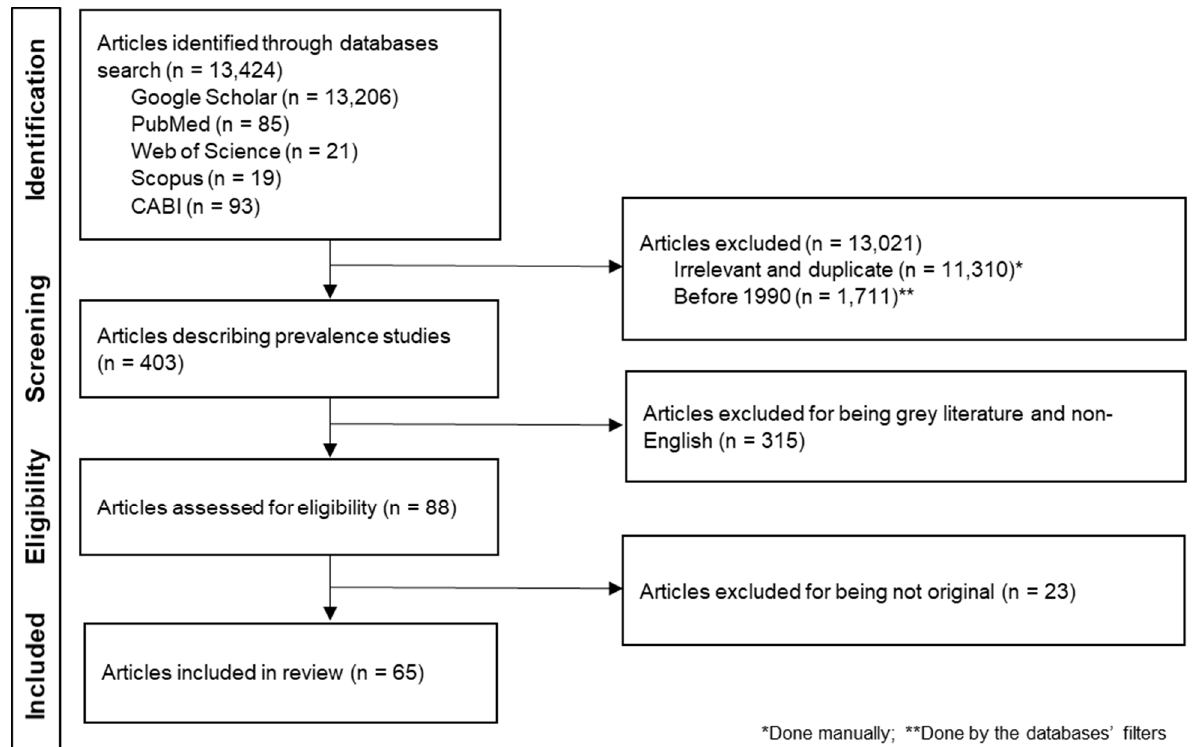
Figure 1. Flow diagram of the literature source and search strategy.